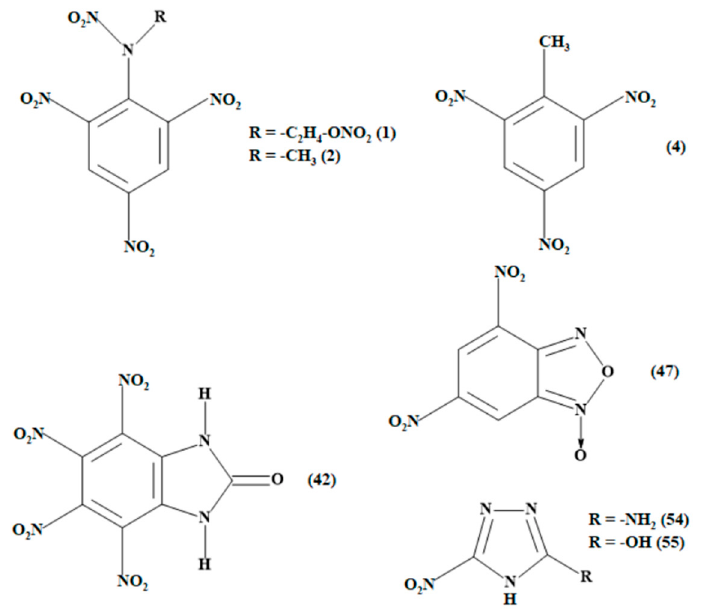
Figure 3. Formulas of nitroaromatic explosives: pentryl ( 1 ), tetryl ( 2 ), 2,4,6-trinitrotoluene (TNT) ( 4 ), 4,5,6,7-tetranitrobenzimidazolone ( 42 ), 4,6-dintrobenzofuroxane ( 47 ), ANTA ( 54 ), and NTO ( 55 ). The numbers of compounds correspond to those in Table A1 (Appendix A).